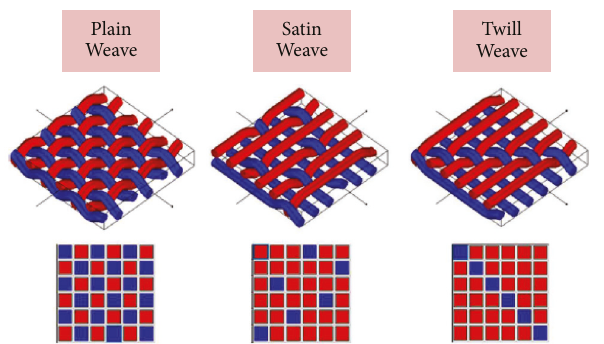
Figure 3: Schematics for different weave structures [26].